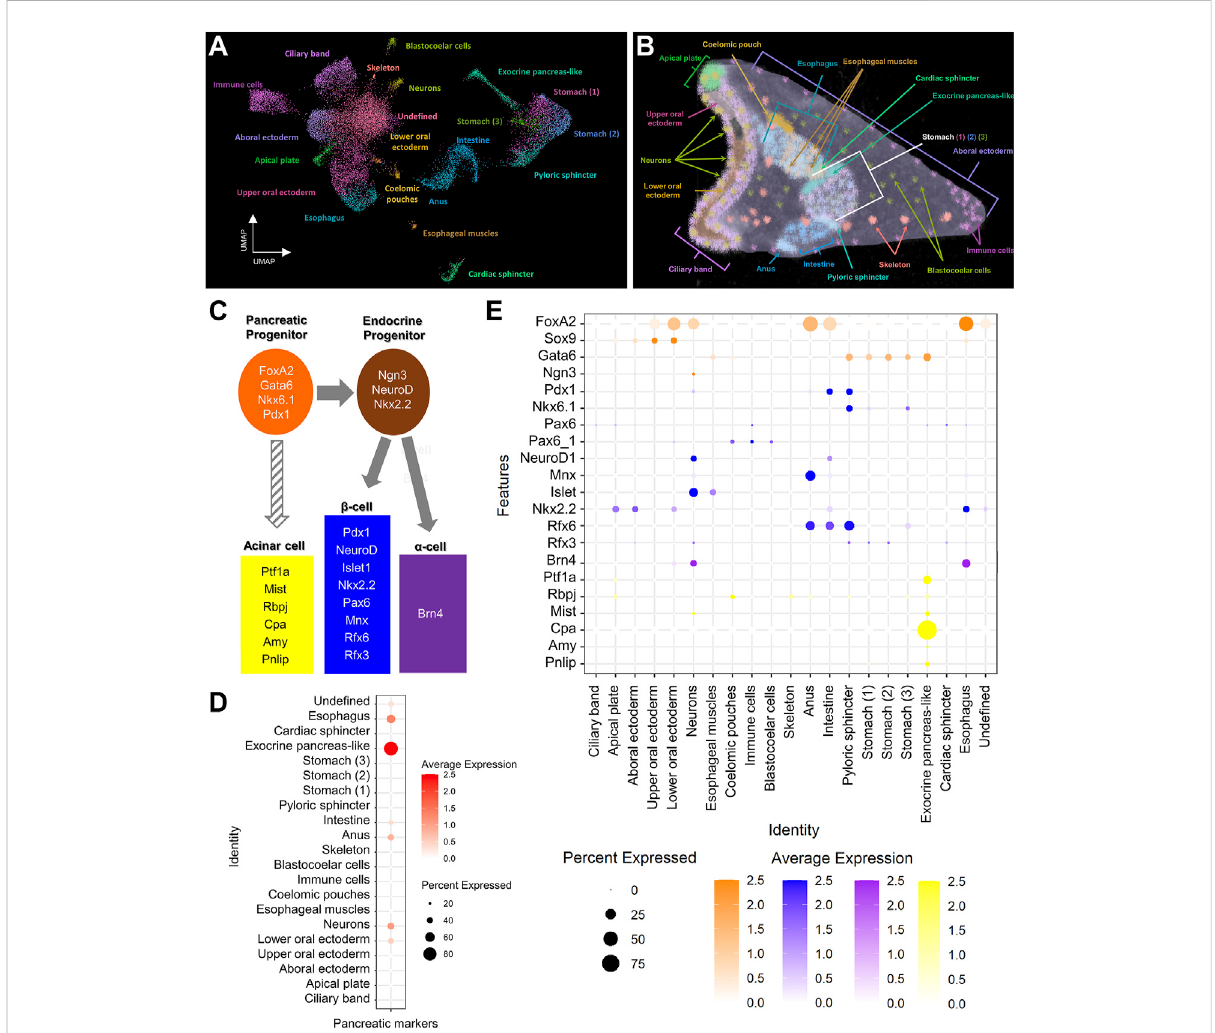
FIGURE 1 Pancreatic-like molecular signature of the S. purpuratus larva cell type families. (A) Uniform Manifold Approximation and Projection (UMAP) showing the 3 dpf S. purpuratus cell type families (modi fi ed from Paganos et al., 2021). (B) X-ray Microtomography (MicroCT) of the 3 dpf S. purpuratus pluteus larva, placed in lateral view, in which the different cell type families are labelled with pseudo-coloring. Color code is the same as the one used in (A) . (C) Simpli fi ed schematic representation of pancreatic gene markers known to be present in speci fi c stages of pancreatic development and distinct pancreatic lineages. (D) Dotplot showing the average score of the sea urchin pancreatic marker orthologs shown in (C) across the larval cell type families. (E) Dotplot showing the average expression of the pancreatic markers across the larval cell type families. Color code in (E) is the same as the one used in (C)